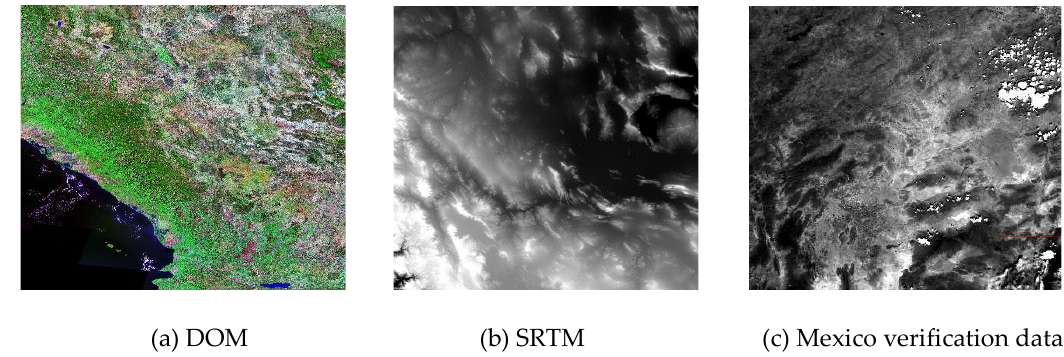
Figure 5. Mexico Torreon regional control and verification data.